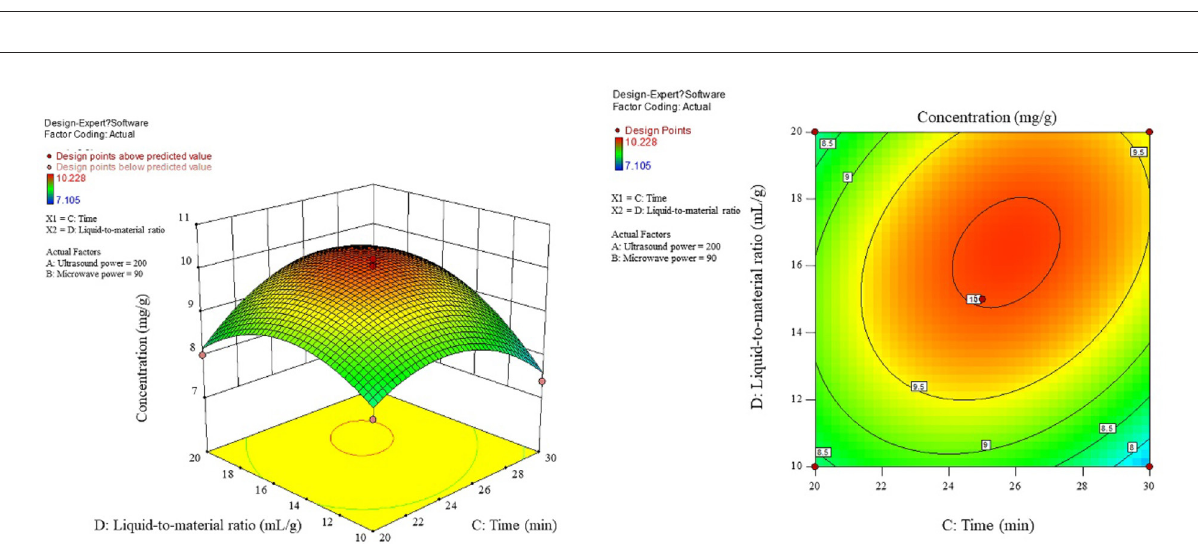
FIGURE7 Effect of the interaction of microwave power and liquid-to-material ratio on content.